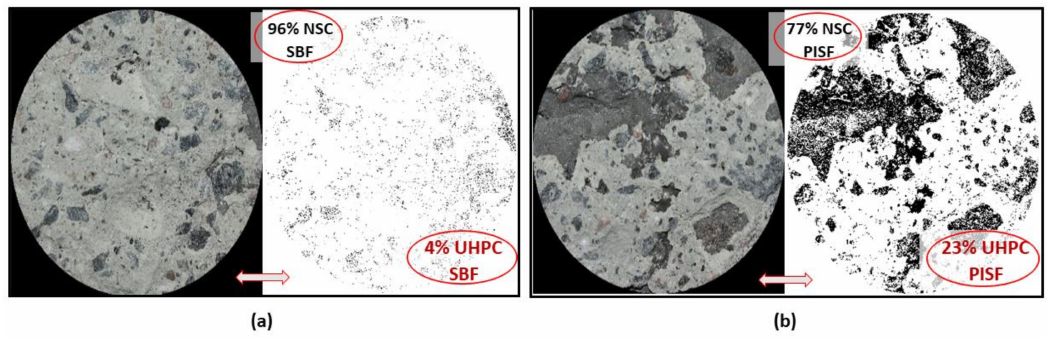
Figure 10. Pull-o ff test—bond strength development of composite specimens at di ff erent sections.